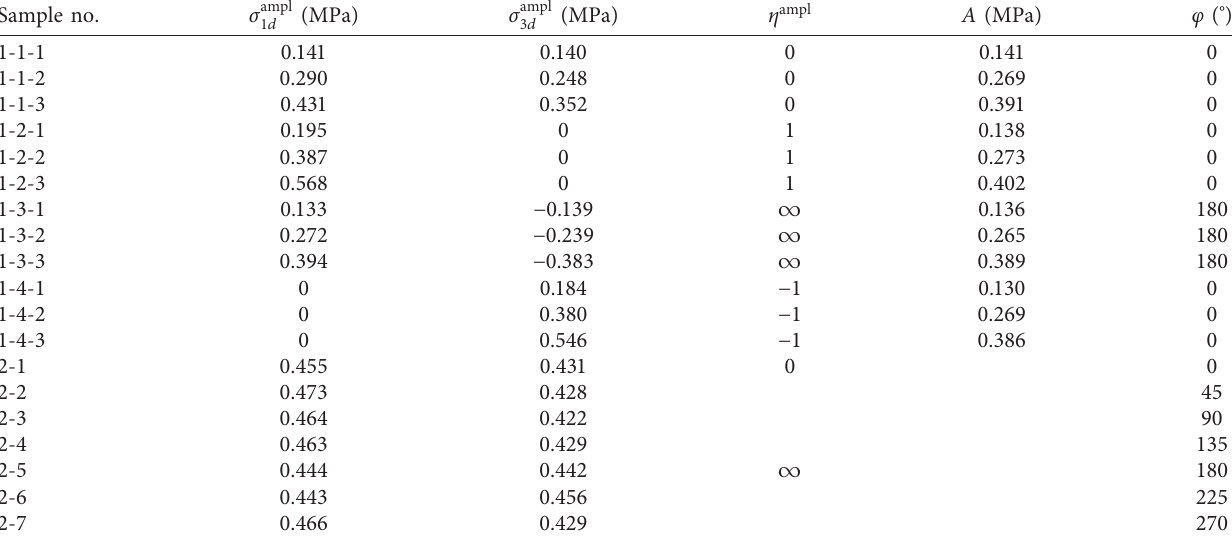
Figure 3: Three types dynamic stress path: (a) the same length under different inclination angles; (b) the different phase difference of principal stress; and (c) the same deviatoric stress amplitude with different inclination Table 2: Details of the test conditions.